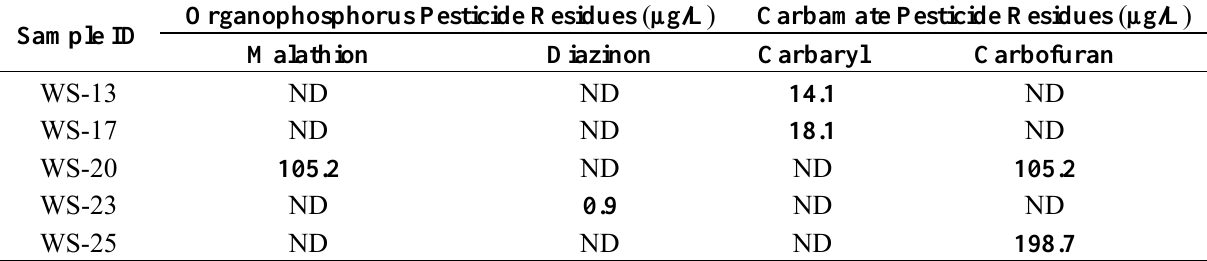
Table showing only WS that contained pesticides residues; organophosphorus and carbamate pesticide residues were not detected in the rest of the samples. WS: Water Sample; ND: Not Detected; WS-17 and WS-20 are samples from Dhamrai Upazila; WS-23 and WS-25 are samples from Savar Upazila. Mean value of triplicates. LOD: 0.01 µg/L. Concentrations in bold are those that exceed levels that are safe for humans, established by the EEC at 0.1 µg/L for any pesticide (or 0.5 µg/L for total